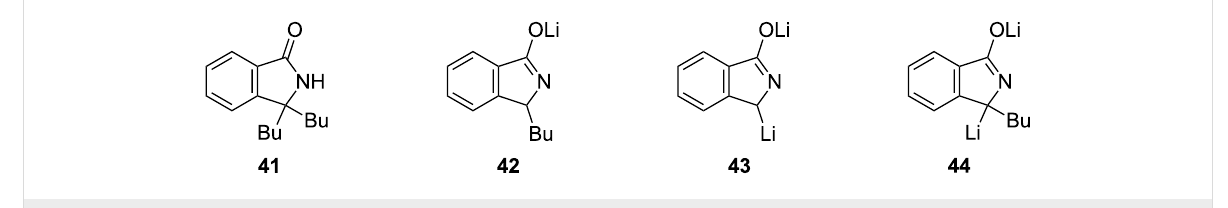
Figure 3: Structures of compounds 41 – 44 .